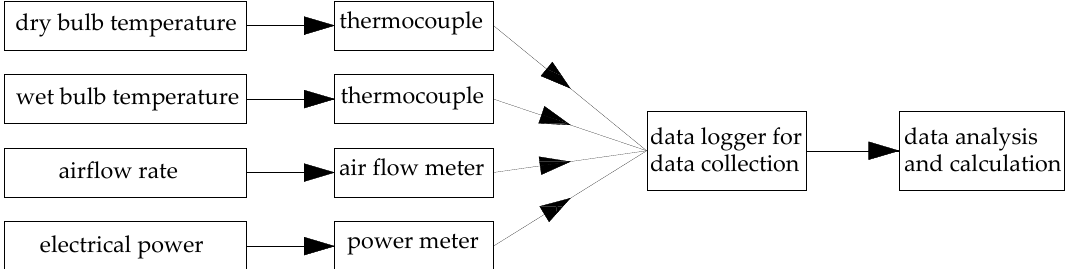
Figure 5. Schematic diagram of data collection.